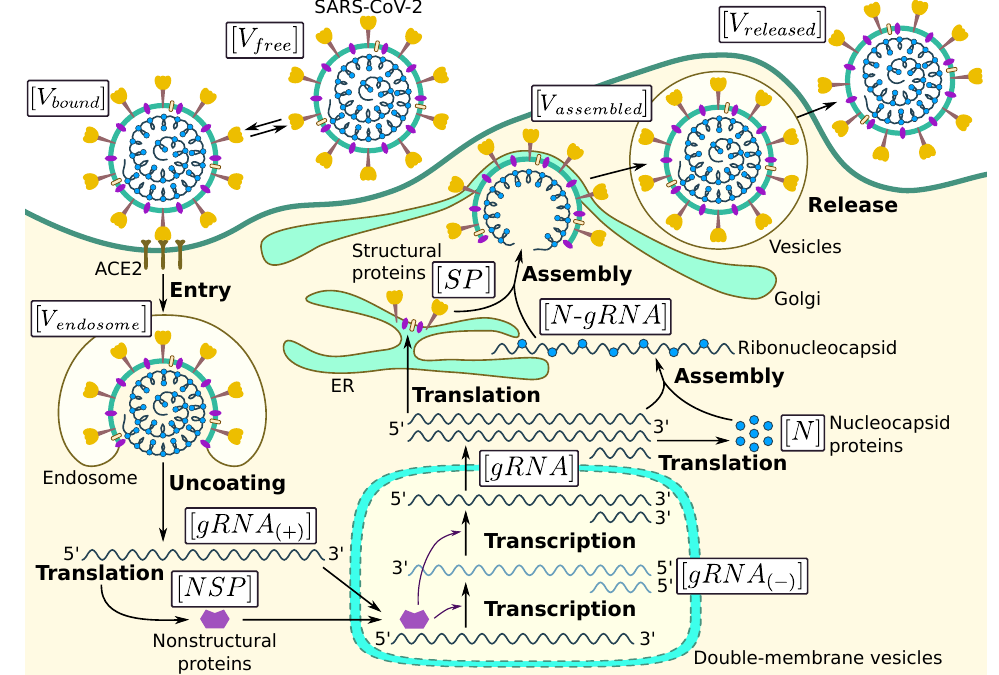
Figure 1. Biochemical scheme of the SARS-CoV-2 replication